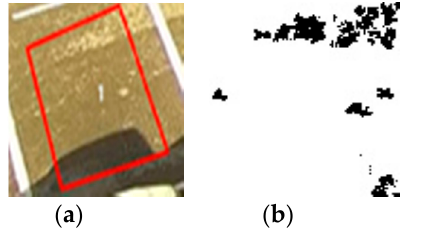
Figure 7. The image of ( a ) available sunny parking space; ( b ) the result of SIFT corner detector. The number of the points of interest from the SIFT corner detector is compared with threshold = 7 and if the value is bigger than the threshold, then status = 1 (occupied space); otherwise, status = 0 (available space).